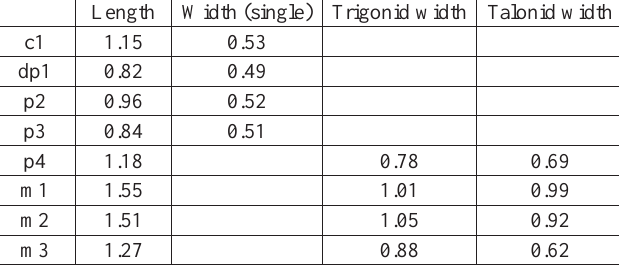
Table 1. Maximum measurements (in mm) of the teeth of the holotype of Darbonetus sigei sp.